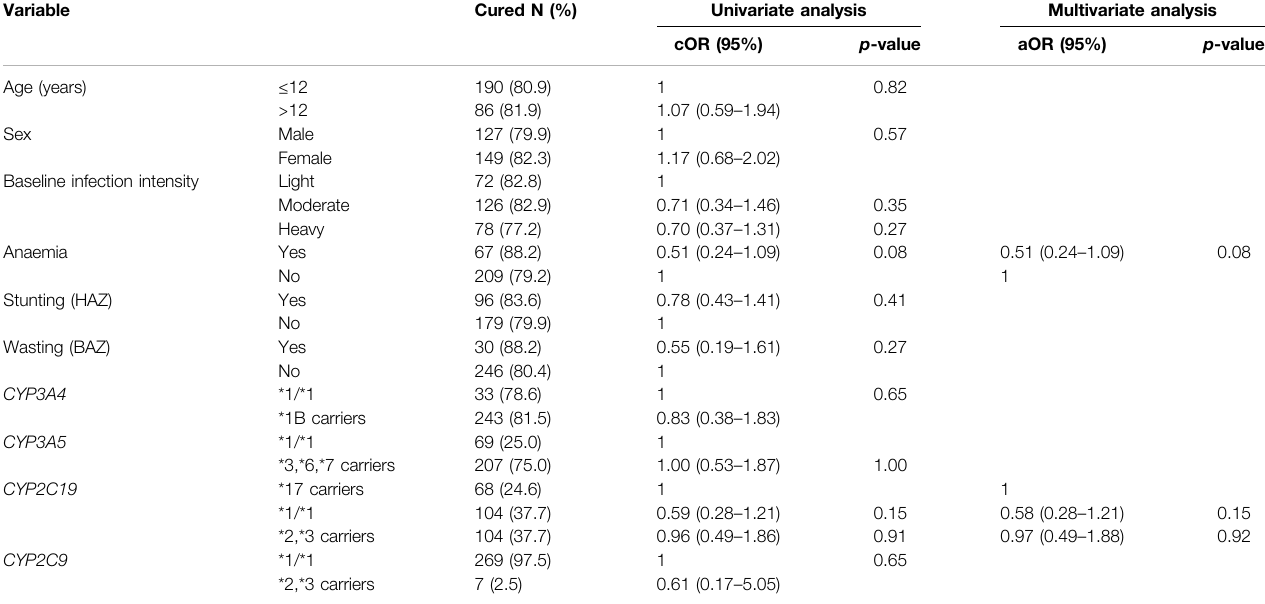
TABLE 5 | Univariate and Multivariate logistic regression analysis for predictors of cure at 3 weeks ’ post-treatment. Variable Cured N